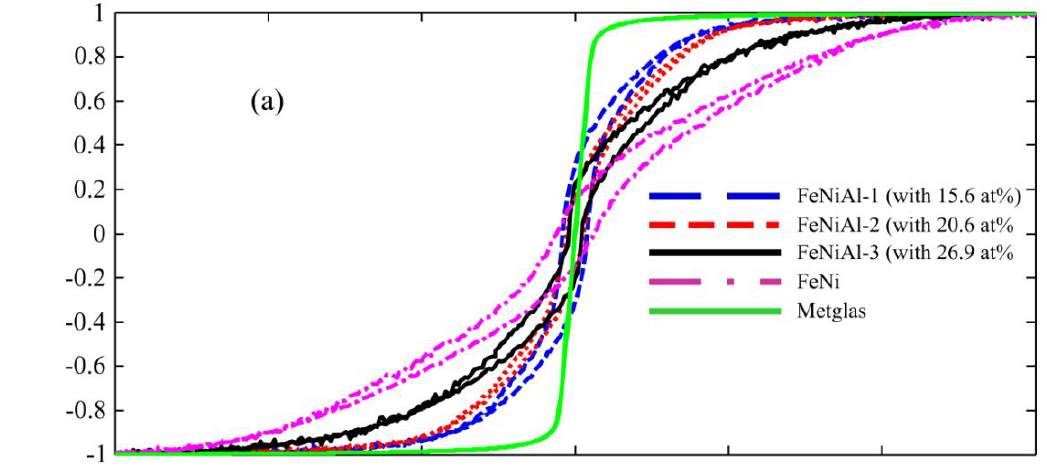
Figure 4. Magnetization loops for ( a ) FeNiAl, ( b ) FeNiMo and ( c ) FeNiB, at various concentrations of Al, Mo and